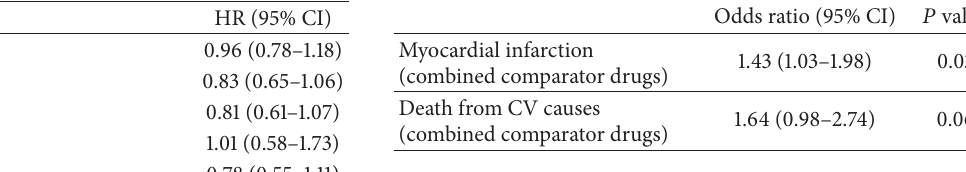
Table 1: PROactive primary end-point results [4].